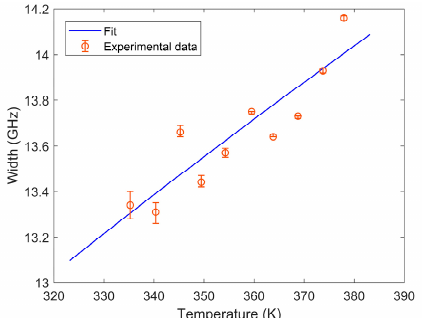
Figure 11. The measured line widths for 87 Rb (D1) as a function of temperature for N 2 (700 Torr at 25°C) with linear fits from Equation (13).